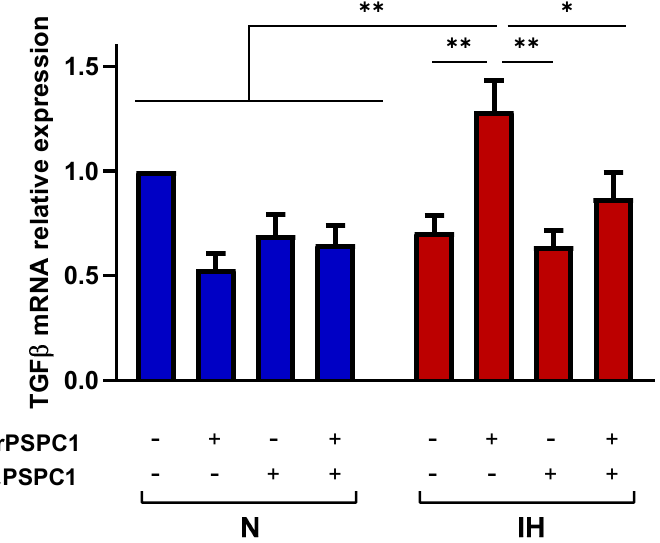
Figure 3. Hypoxemia collaborates with PSPC1 to modulate TGF β expression. The melanoma cell line (C-8161) was cultured under N and IH conditions with rPSPC1 protein (2.5 ng/mL) with or without α -PSPC1 (1 ug/mL) for 16 h. The melanoma cells were then harvested to analyze TGF β mRNA expression by qPCR. The groups were compared using two-way ANOVA. Error bars: SEM. * p < 0.01, ** p < 0.001 are shown.